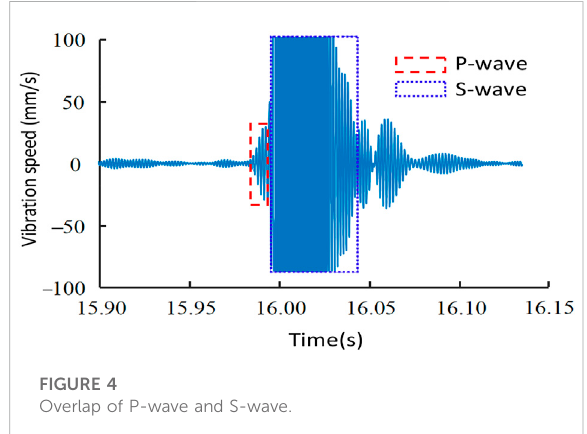
FIGURE 3 Calculation diagram of basic zero-crossing